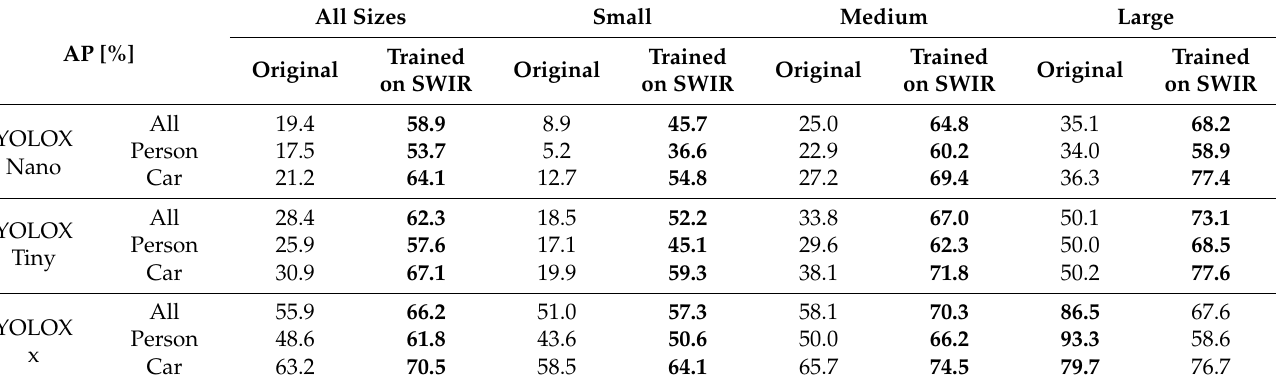
Table 6. Evaluation of the original YOLOX model and our trained YOLOX model on SWIR dataset for people and car detection on SWIR images. Evaluation is performed on labeled SWIR images using the COCO_eval library. Small size object presents objects up to 32 × 32 (1024) pixels, medium: from 32 × 32 (1024) to 96 × 96 (9216) pixels, and large objects with sizes greater than 96 × 96 (9216) pixels. Performance is presented with Average Precision (AP)